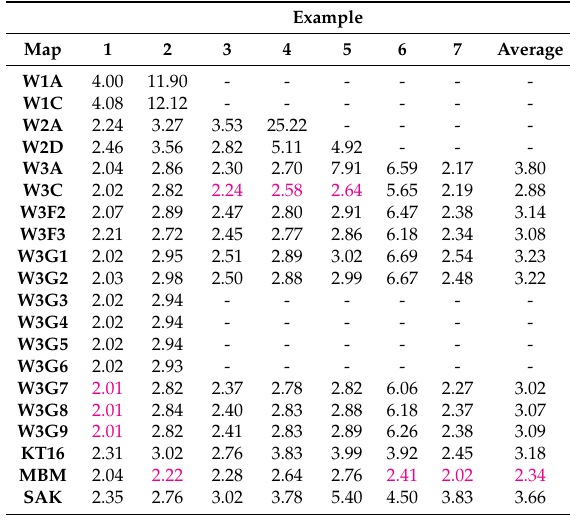
Table 5. Average number of iterations per point for each example (1–7). Example